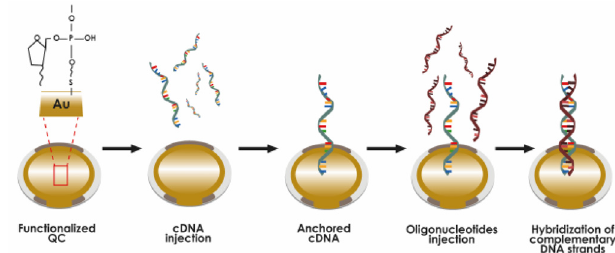
Fig. 2. Diagram of functionalized gold surface quartz crystal and representation of the cDNA anchorage and hybridization.